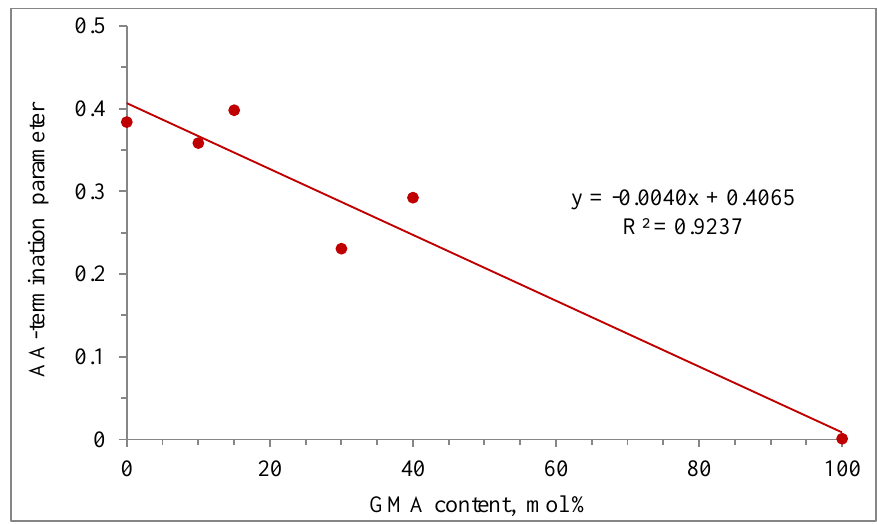
Figure 11. Linear regression of the AA-termination parameters vs. GMA content.